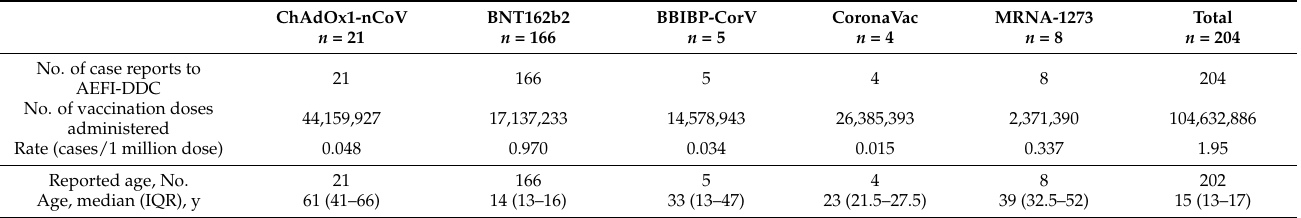
Figure 1. Flow chart of the study. Table 1. Characteristics of the myocarditis/pericarditis cases following immunization in Thailand.